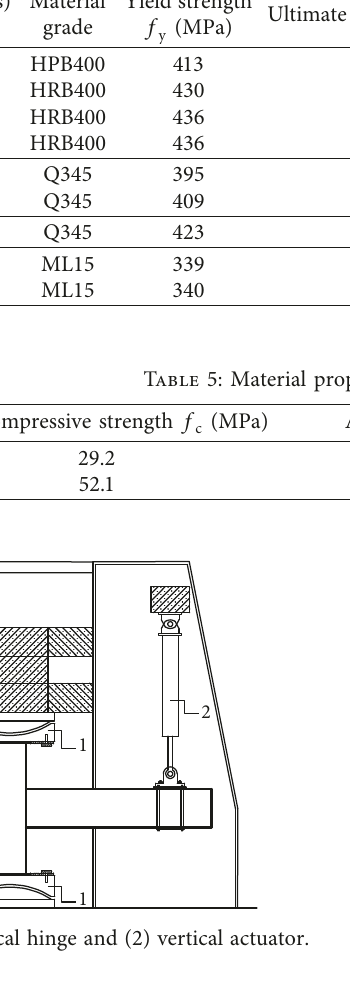
Table 4: Material properties of steel.